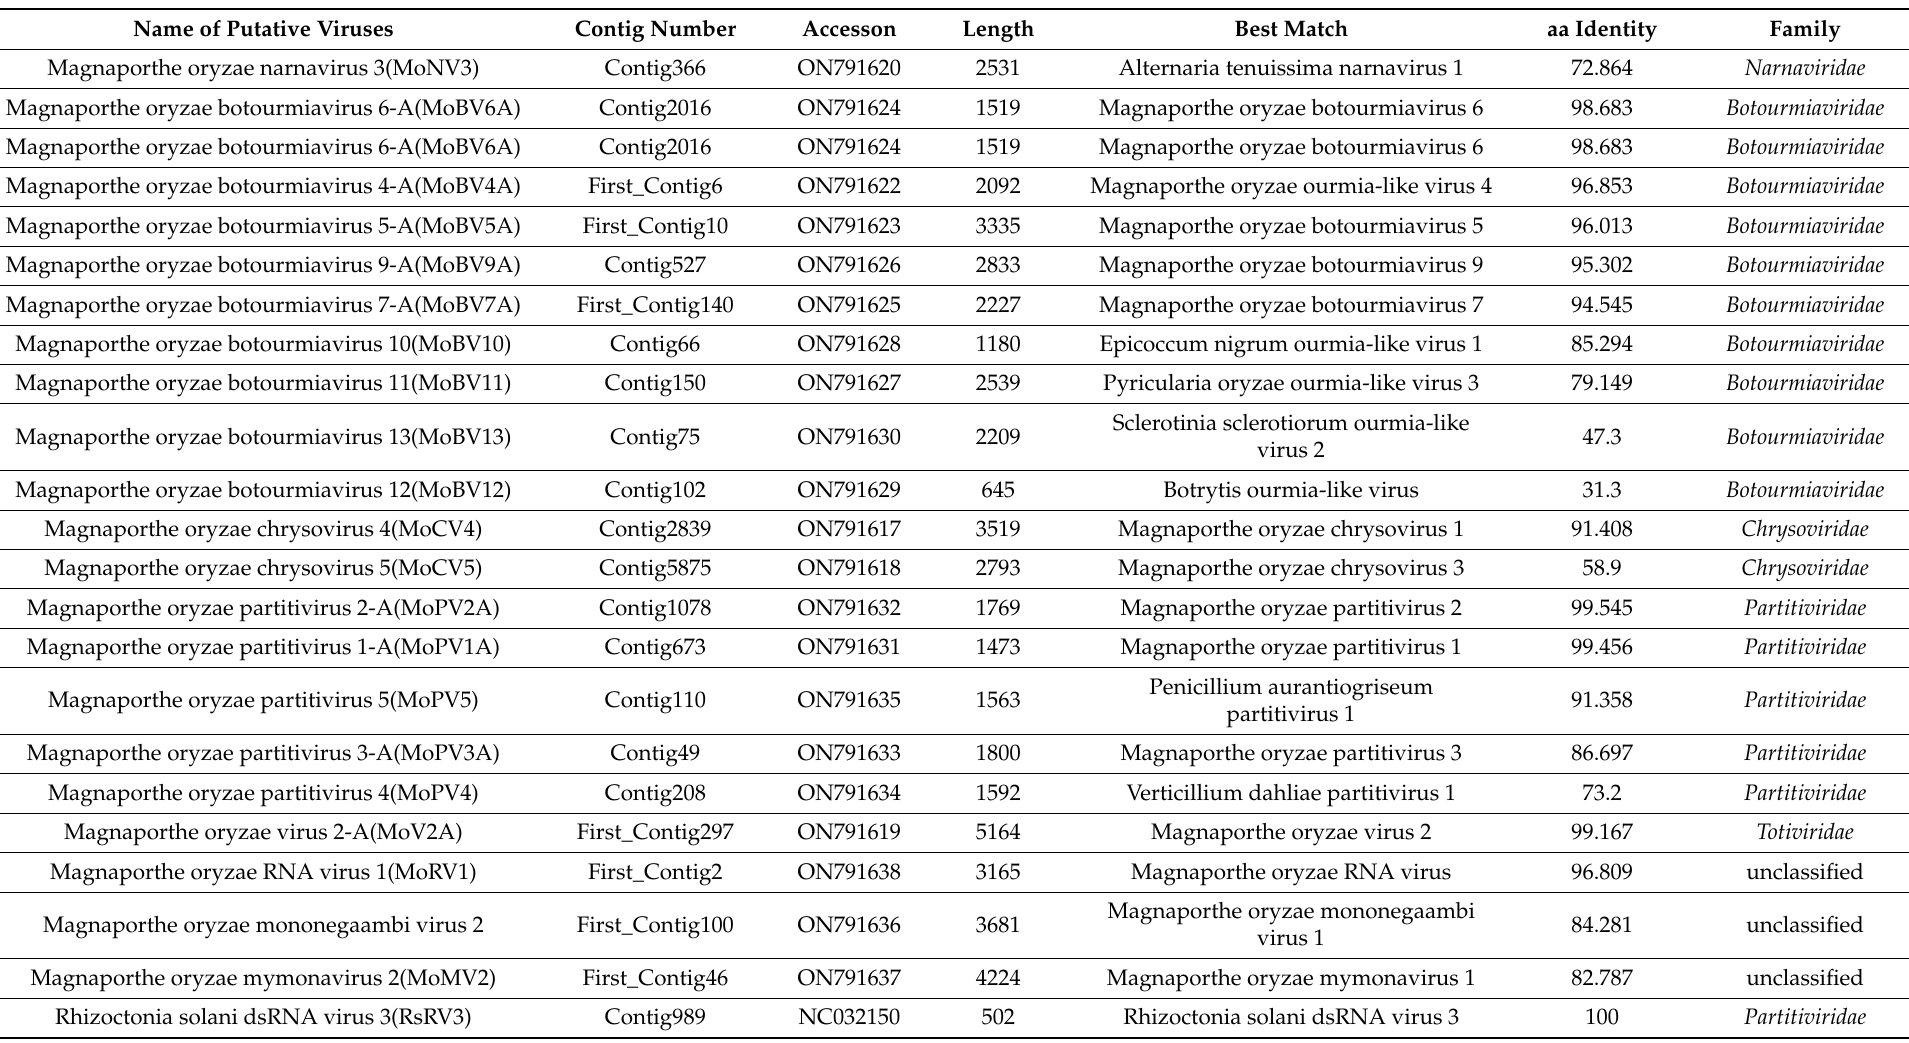
Table 1. Assembled sequences with similarity to those of previously described